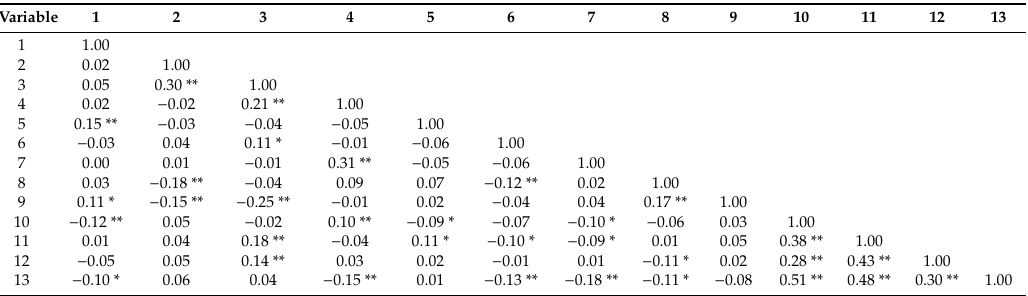
Table 4. Pearson correlation for variables included in regression analysis.